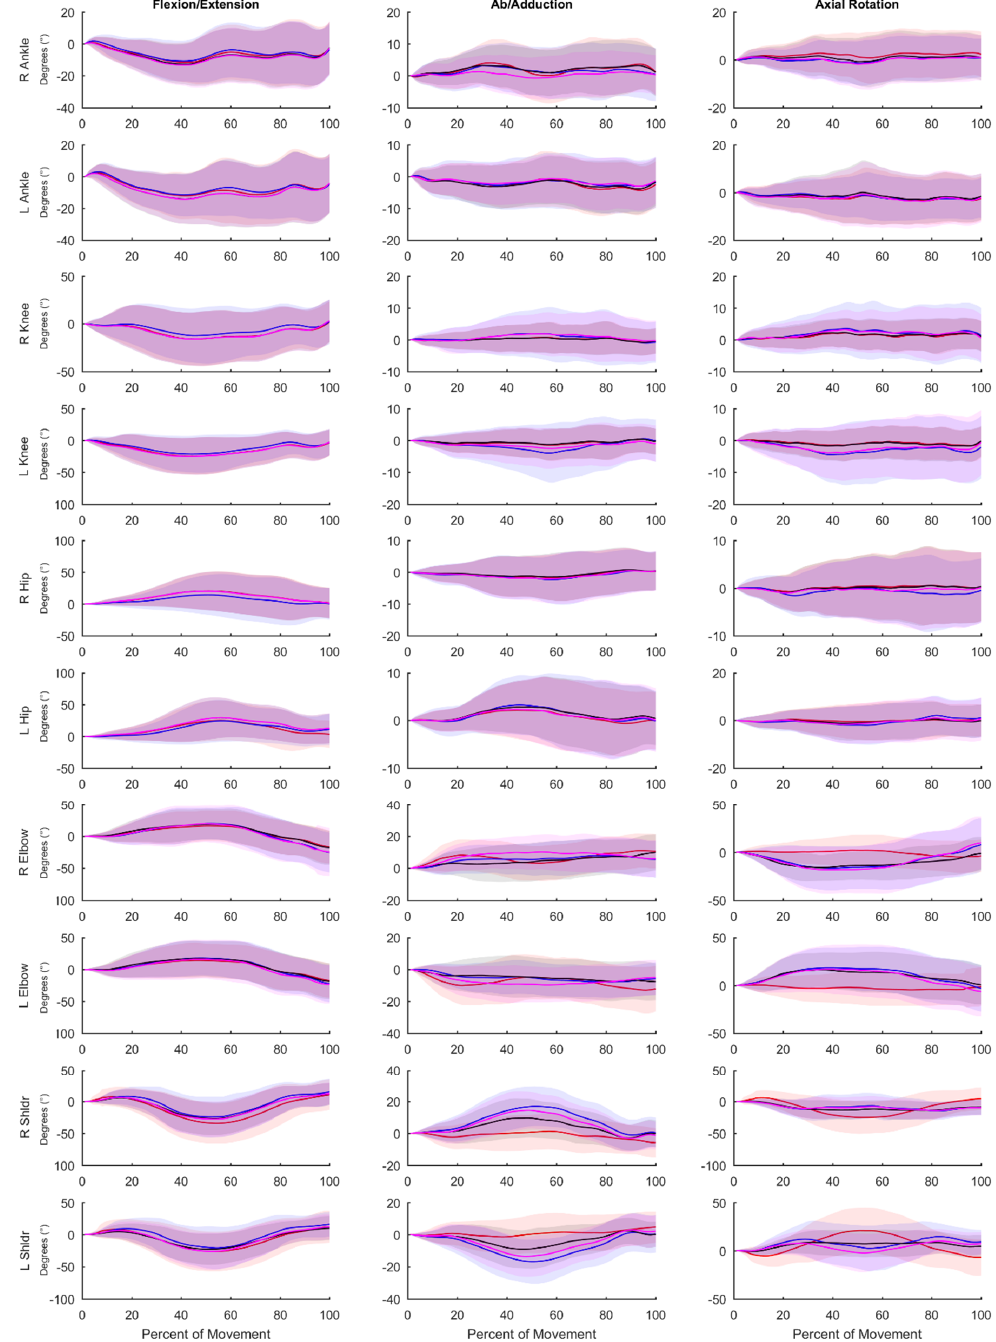
Figure 5. Average waveforms across all movements. Blue represents data captured through OPT (V OPT ); red represents data captured through IMU (X IMU ); black represents IMU data processed through Visual3D (V IMU ); magenta represents IMU data processed through Visual3D with the coordinate system alignment procedure (V IMU-CAL ). Shaded areas represent one standard deviation from the mean trajectory and are displayed in the same colour.